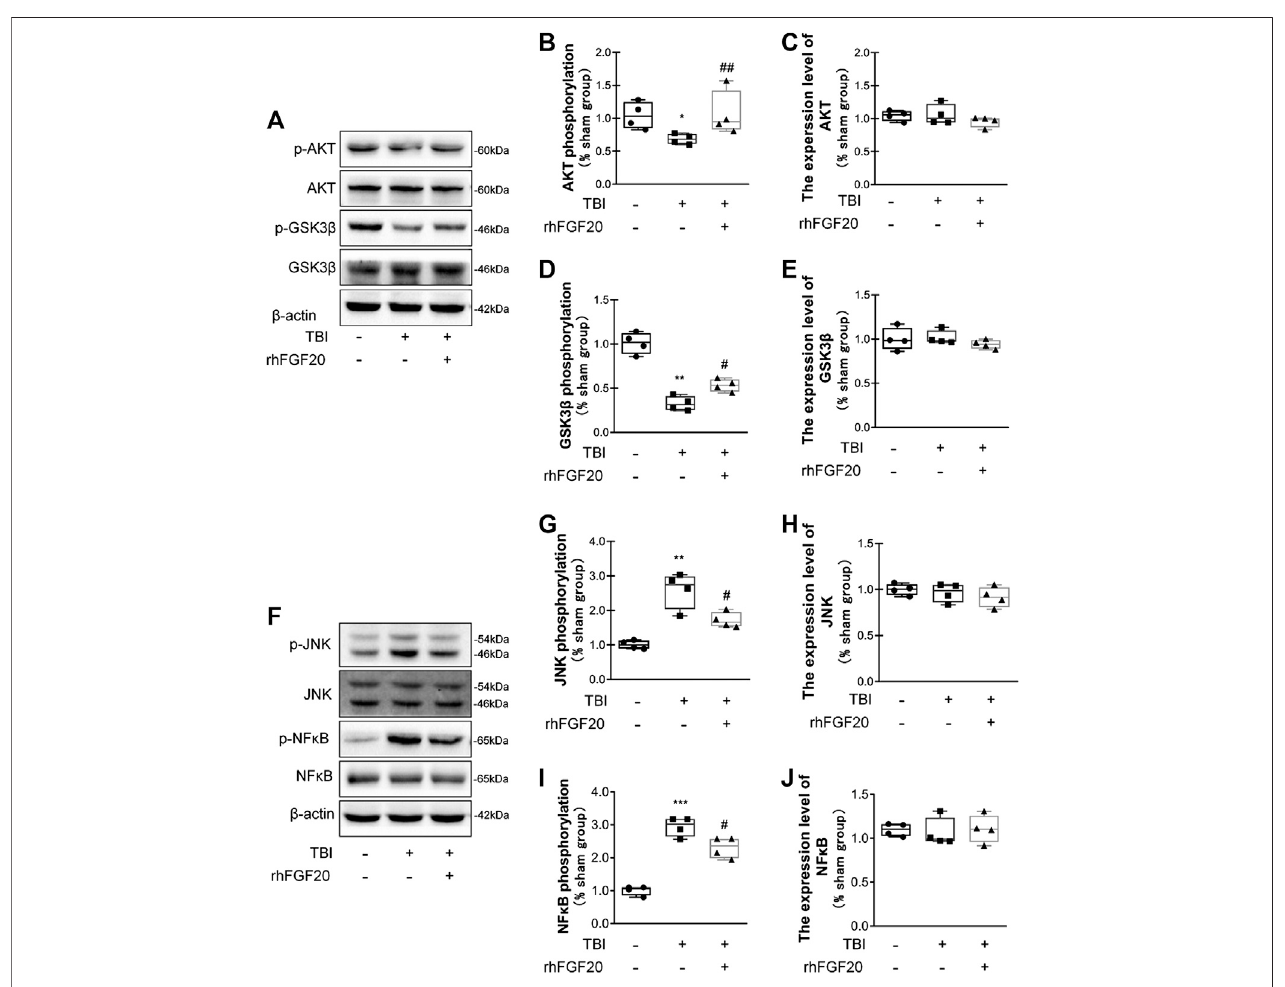
FIGURE 5 | Exogenous rhFGF20 improved recovery after TBI via the AKT/GSK3 β and JNK/NF κ B signaling pathways (A) Representative image of western blot analysis of p -AKT, AKT, p -GSK3 β and GSK3 β in the mouse brain 24 h after TBI (B – E) Effects of rhFGF20 on p -AKT, AKT, GSK3 β and p -GSK3 β protein levels, as analyzed by quanti fi cation of western blot data ( n (cid:1) 4) (F) Representative images from western blot analysis of p -JNK, JNK, p -NF κ B and NF κ B. β -Actin was used as the loading control and for band density normalization (G – J) Effects of rhFGF20 on the p -JNK, JNK, p -NF κ B and NF κ B protein levels, as analyzed by quanti fi cation of western blotting data ( n (cid:1) 4).* p < 0.05, ** p < 0.01, *** p < 0.001 vs. sham group. # p < 0.05, ## p < 0.01 vs. the TBI group. Data are presented as the mean values ±